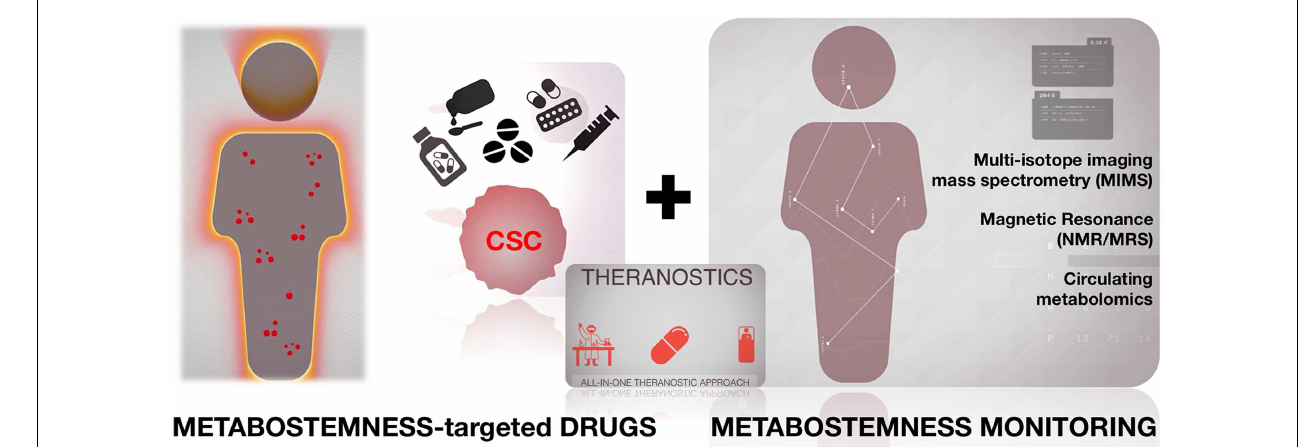
minimizing sequelae.The specific, efficient elimination of the malignant teratocarcinoma-initiating cells using the metabolic drug metformin (198) strongly supports the suggestion that the phenomic metabostemness hallmark is a previously unrecognized, indispensable component of the CSC machinery. In addition, the phenomic metabostemness hallmark will allow an “all-in-one” therasnostic approach in cancer diseases, an emerging tool in drug discovery and commercialization that might allow us to take pharmacometabolomics-based precision medicine from the lab to the “point-of-care,” the patient. Should CSC possess specific changes in the capacities and kinetics of certain metabolic nodes, the unique metabolic flux imprints generated by CSC could be revolutionarily implemented to monitor the spatio-temporal distribution and functionality of CSCs in real-time. Coupling metabostemness-based drug testing with the use of non-invasive devices (e.g., MIMS, NMR/MRS, and circulating metabolomics) that can accurately monitor in real-time the spatio-temporal distribution and functionality of CSC could be rapidly implemented to help surgeons, radio-oncologists, and oncologists accelerate and improve metabostemness-based drug discovery and development (note: the illustrations accompanying the figure were created by “Formas Naturales”: